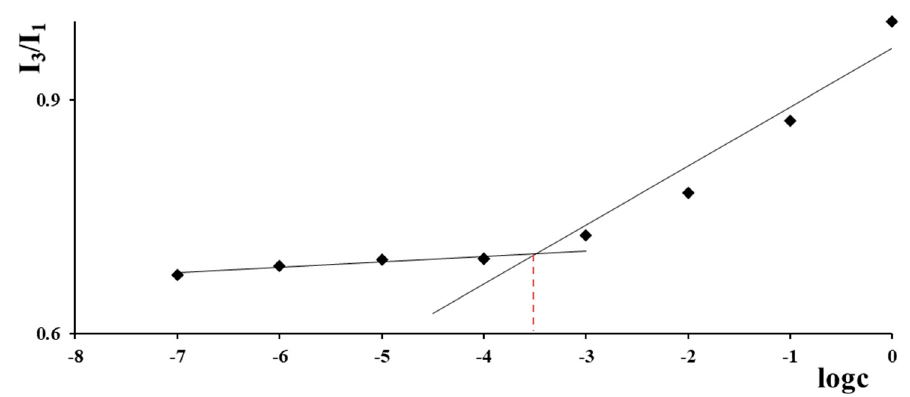
Figure 2. Dependence of the pyrene fluorescence spectrum signals on DC concentration in PBS 0.01 mol L − 1 , pH 7.4.